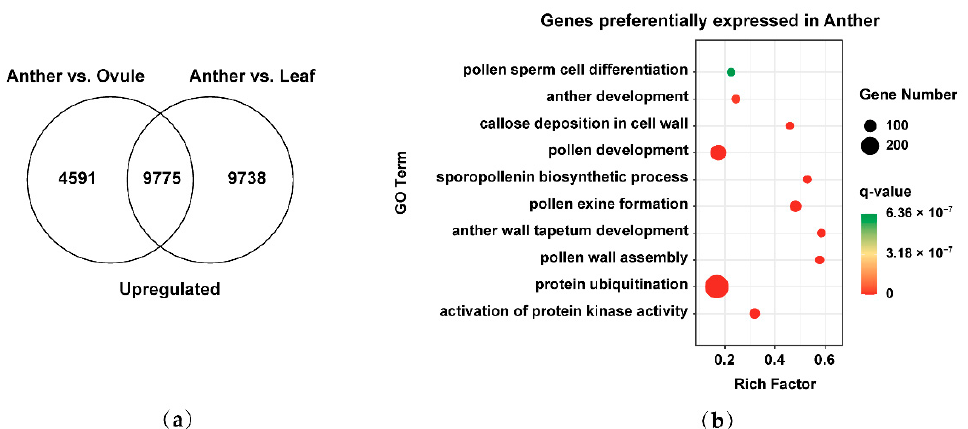
Figure 4. Identification and functional analysis of preferentially expressed genes in male gamete development of Brassica allohexaploids: ( a ) Venn diagram showing the overlap of upregulated genes between Anther vs. Ovule and Anther vs. Leaf and ( b ) GO biological process pathway enrichment analysis of preferentially expressed genes in Anther.